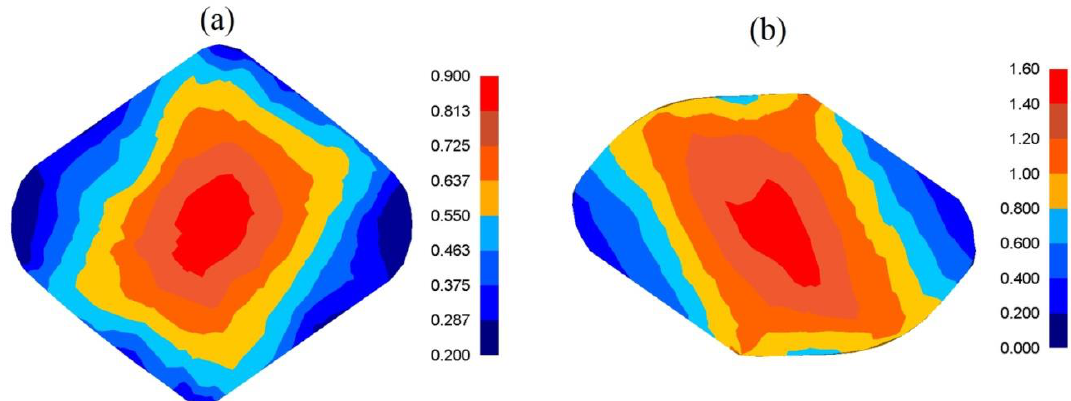
Figure 8. Distribution of the effective strain after the cogging process in anvils with skew working surfaces: ( a ) after the second pass (reduction ratio 0.70); ( b ) after the fourth pass (reduction ratio 1.40) .